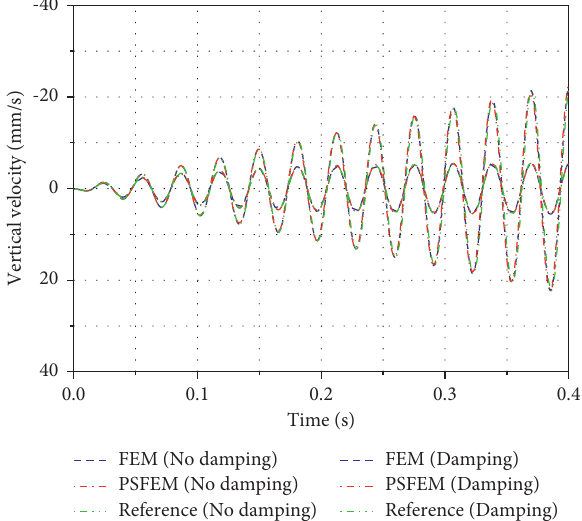
Figure 15: Time history of the vertical velocity.